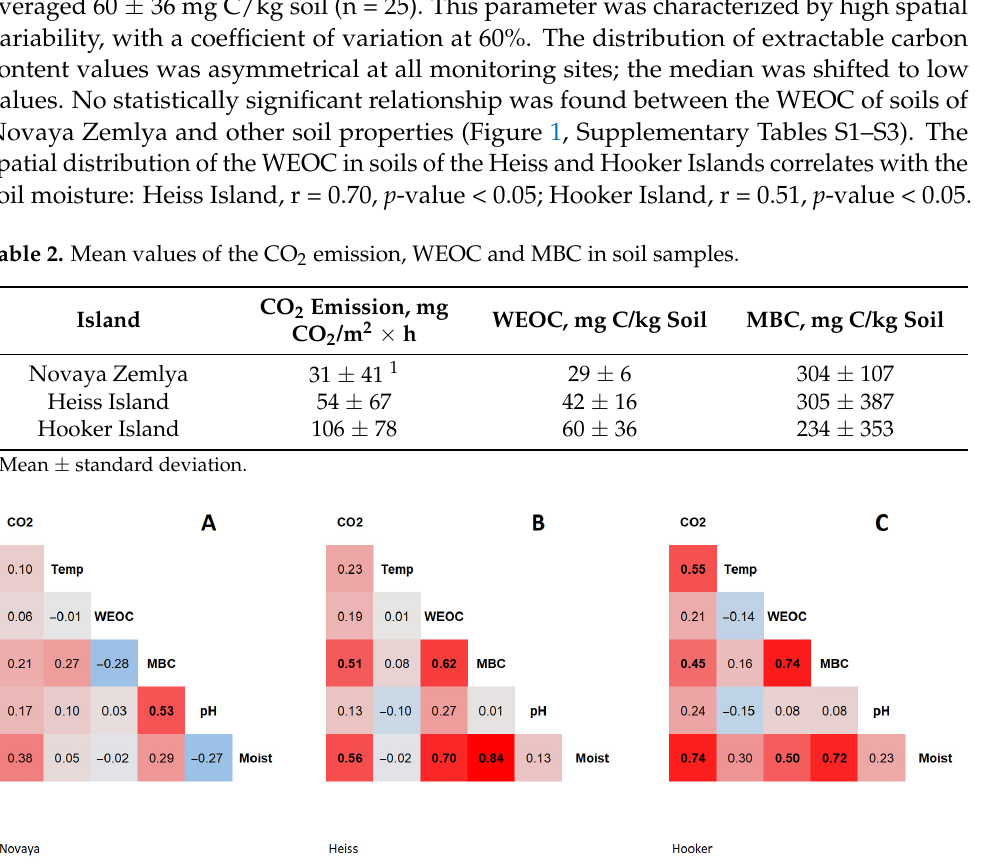
Figure 1. Heatmap of correlations between soil parameters: ( A )—Novaya Zemlya, ( B )—Heiss Island, ( C )—Hooker Island. CO 2 —CO 2 emission, Temp—temperature, WEOC—water-extractable organic carbon, MBC—microbial biomass carbon, Moist—moisture.